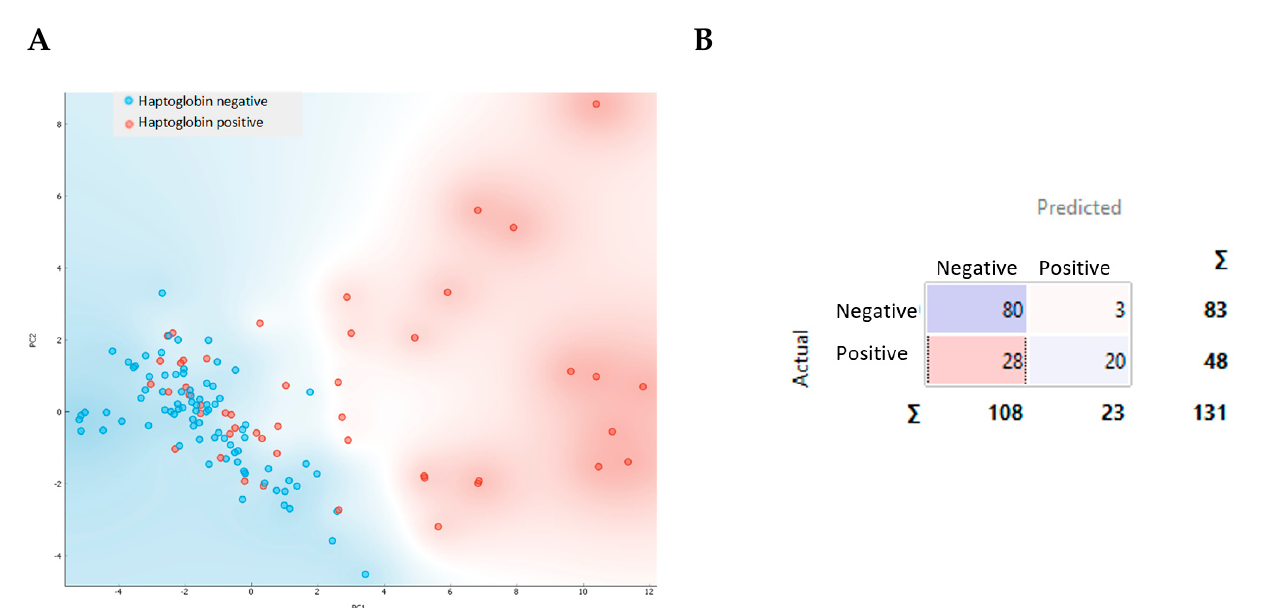
Figure 5. Principal component analysis with the projection of components one and two for the samples according to haptoglobin results, in red for positive and in blue for negative ( A ), and the confusion matrix obtained ( B ).